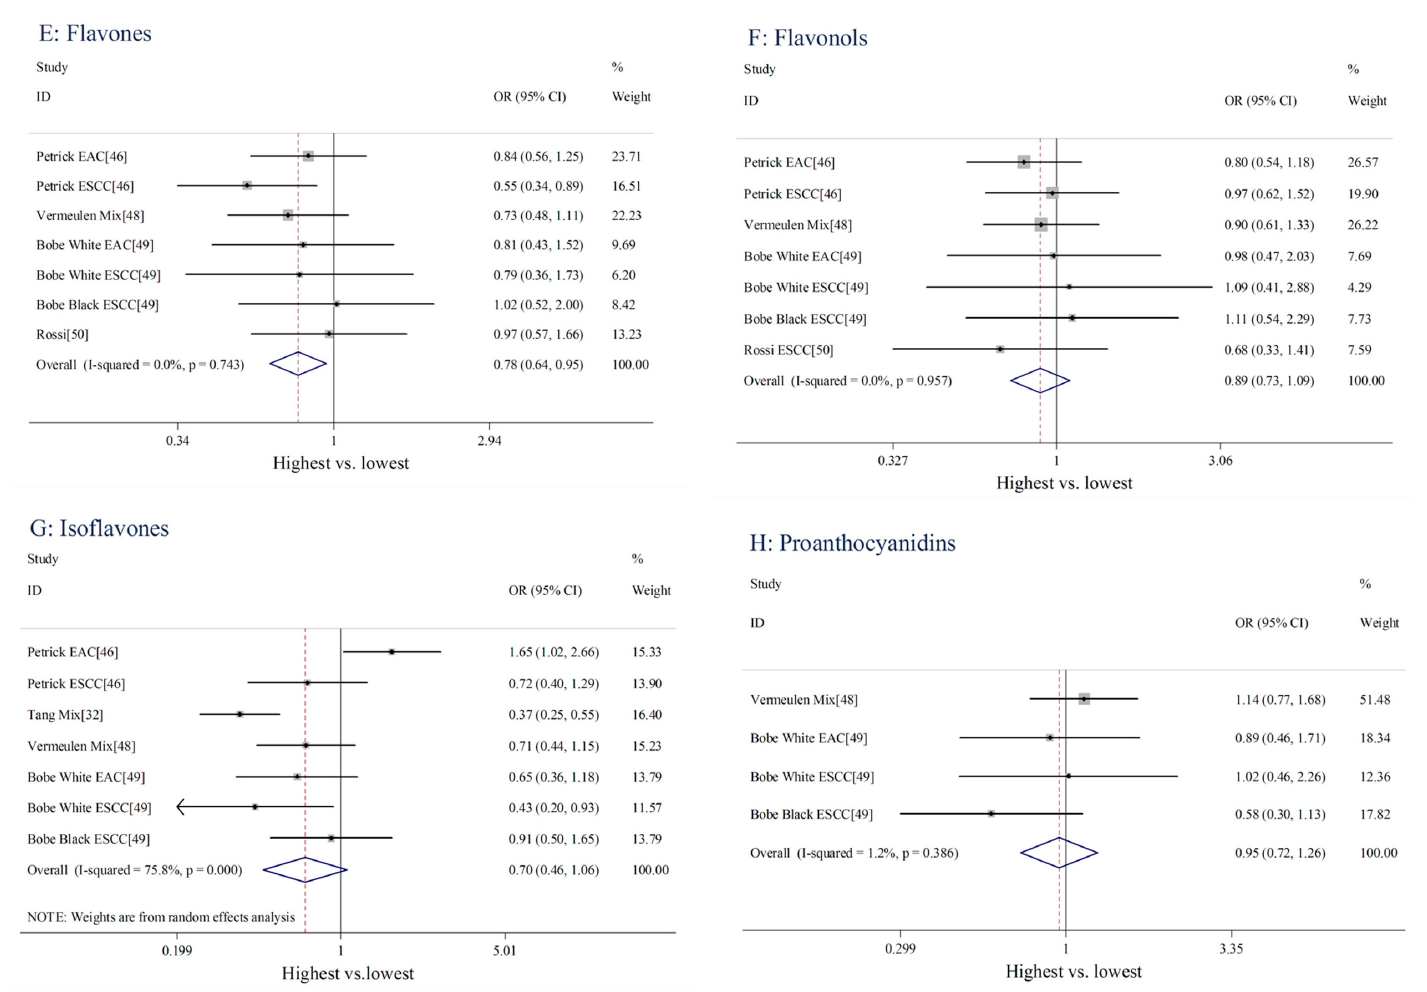
Figure 2. Forest plots for the association between dietary flavonoid intake and esophageal cancer risk (highest vs. lowest categories).